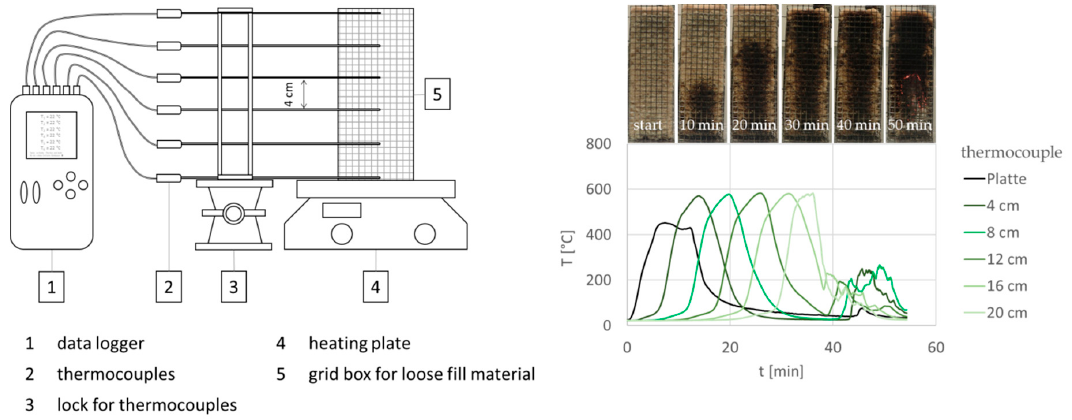
Figure 12. Left , Scheme of the experimental setup for smoldering measurements of loose wood fiber; right , exemplary temperature curves with photos of the fibers as a function of smoldering time.